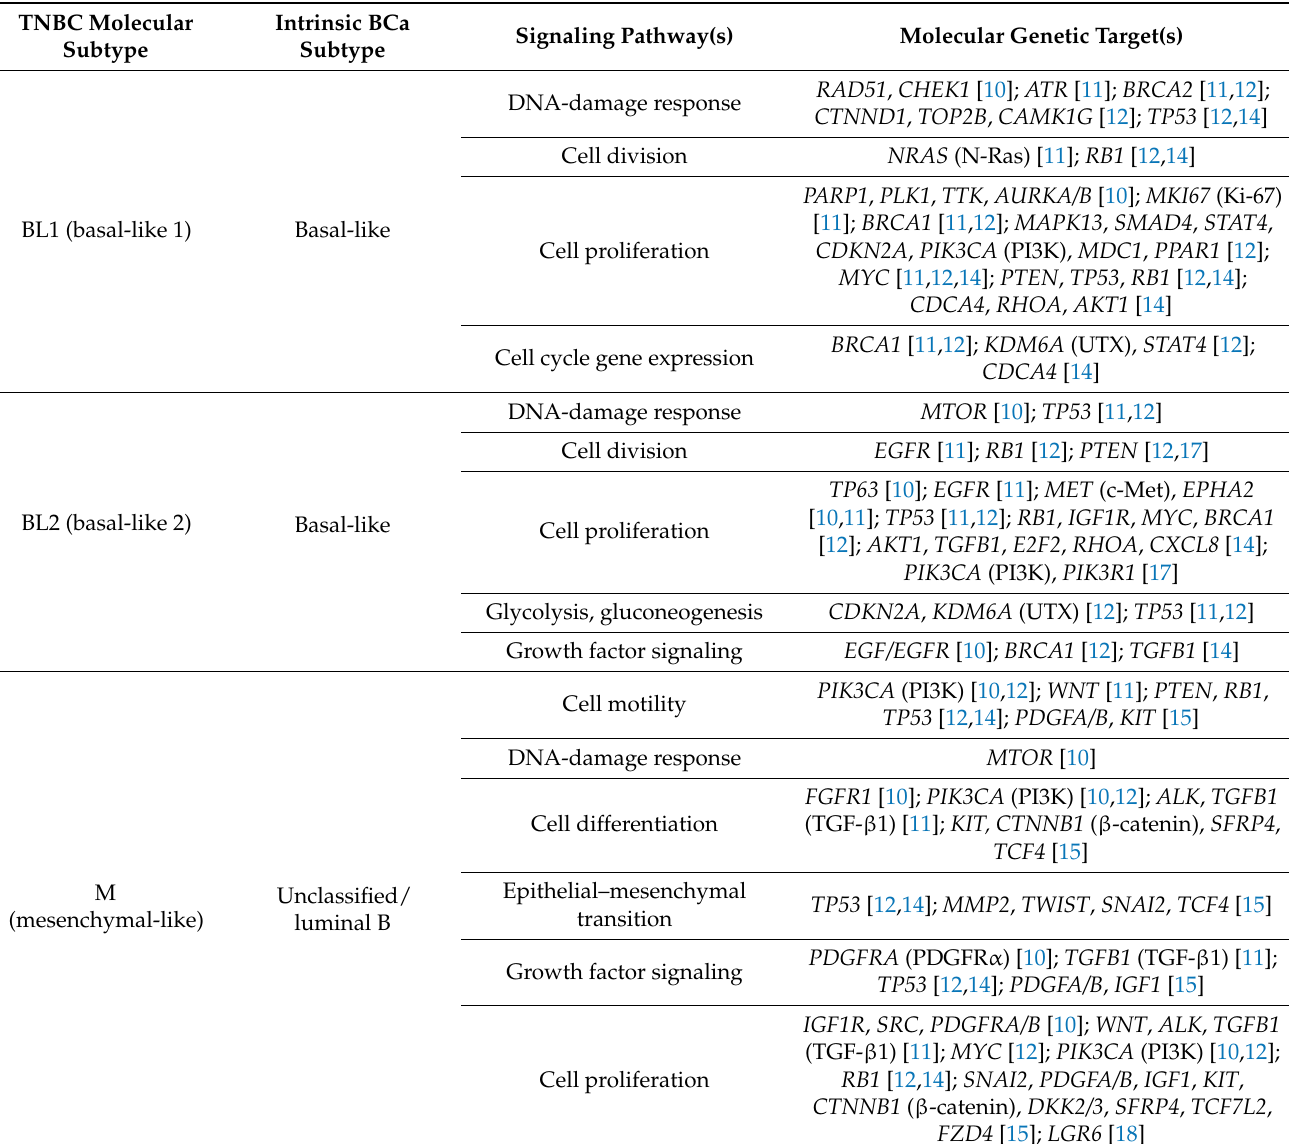
Table 1. Molecular classification of TNBC subtypes according to genetic abnormalities and implicated signaling pathways